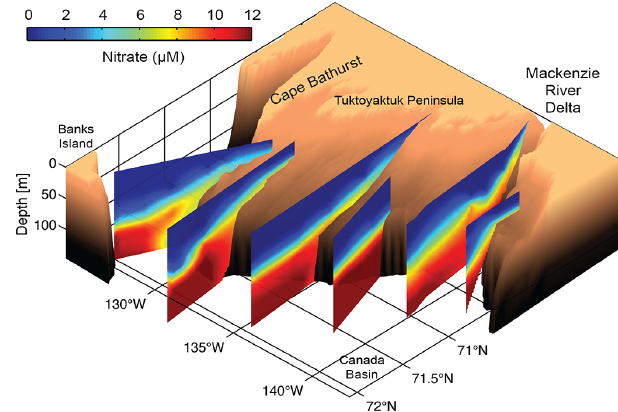
Figure 6. Three-dimensional view of the Mackenzie Shelf region showing the nitrate concentration as measured at transects 100, 200, 300, 400, 600 and 700 (from left to right) during the Malina expedi- tion (Fig. 1). Each vertical slice corresponds to a gridded compos- ite of nitrate concentration measured at standard depths along the cross-shelf sampling